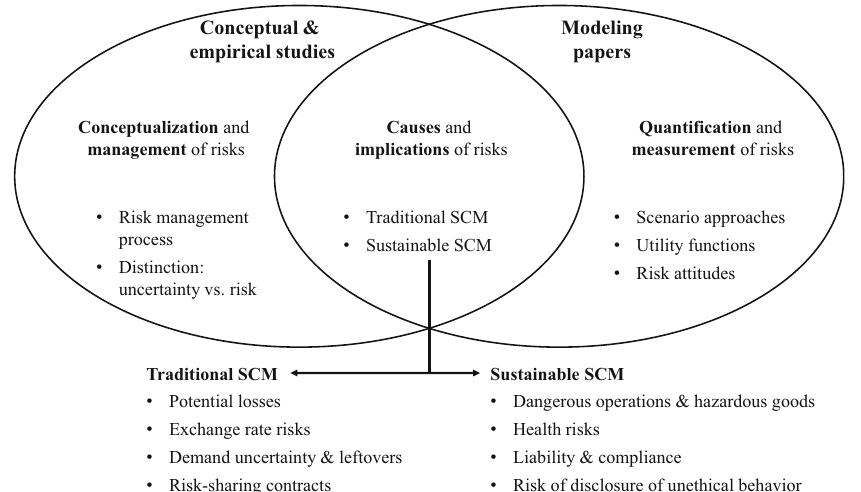
Fig. 6 Similarities and differences regarding risk